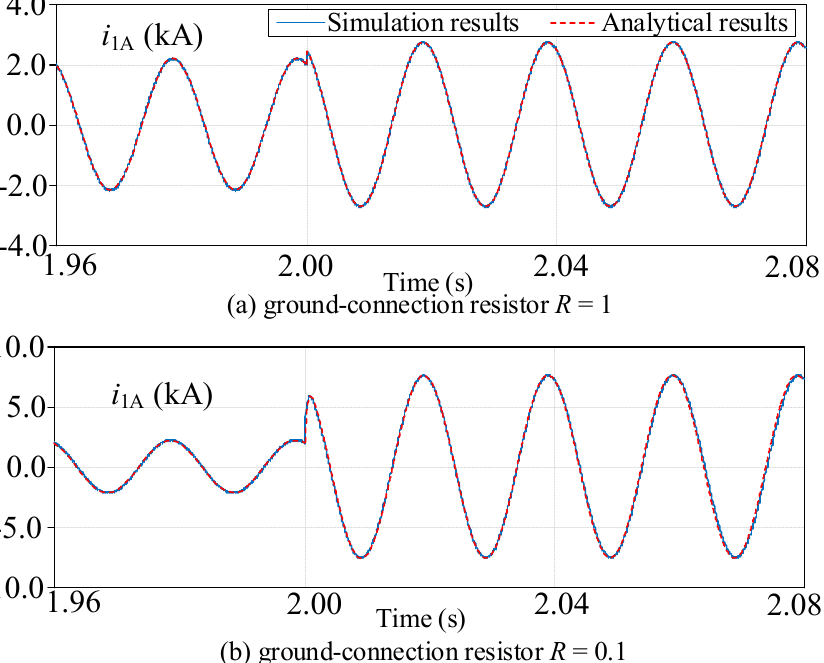
Figure 9. Simulation results of the wind turbine’s output current with different ground-connection resistor when the short-circuit fault occurs.